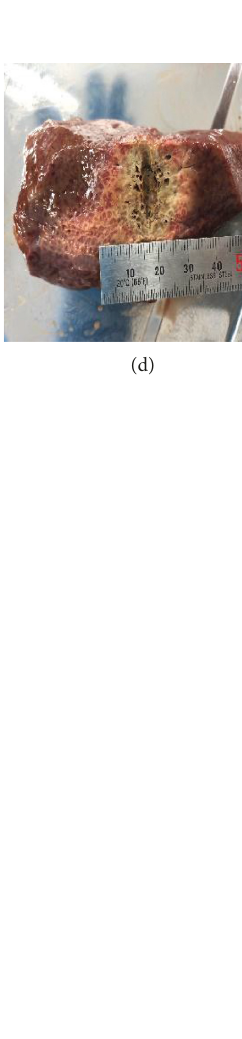
Figure 9: Temperature changes over time on the swine liver: (a) start, (b) 30sec, (c) 60sec, and (d) 90sec.